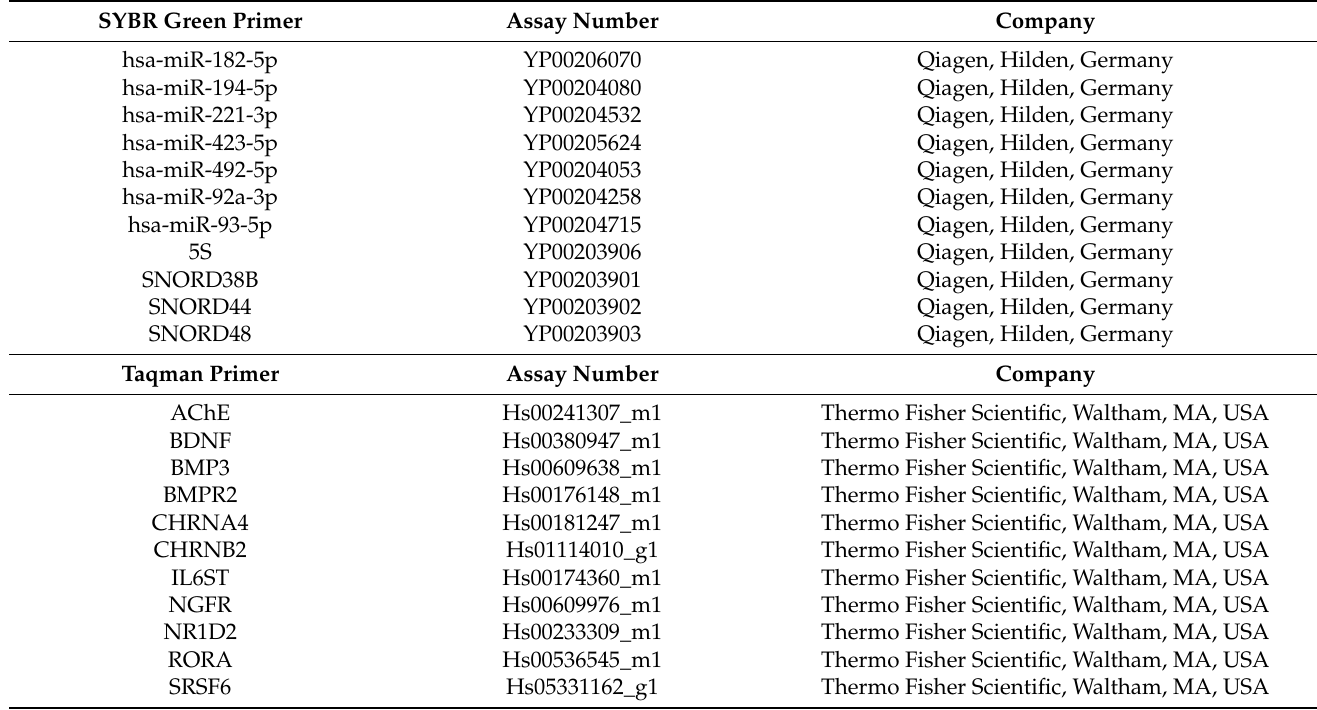
Table 1. List of applied primer